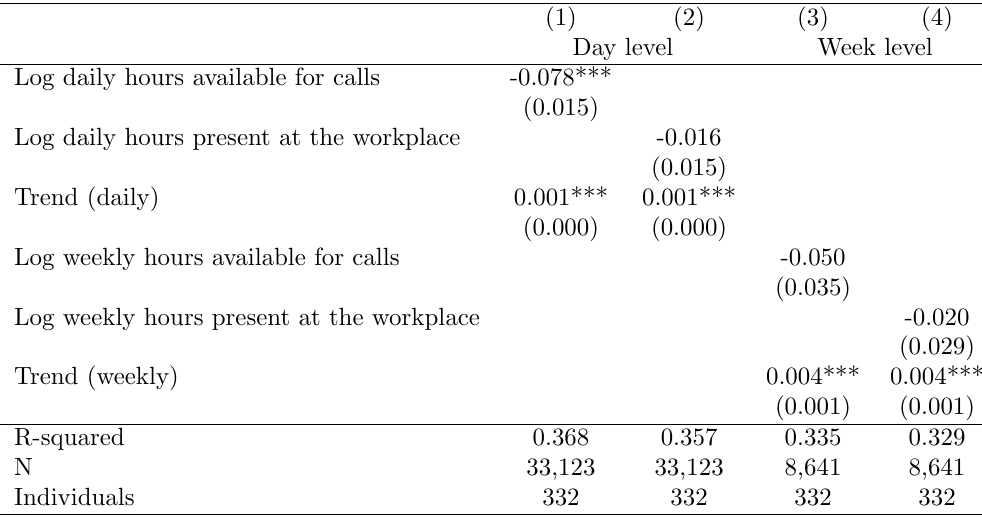
Table 5: Alternative working time definitions and the relationship between productivity and working